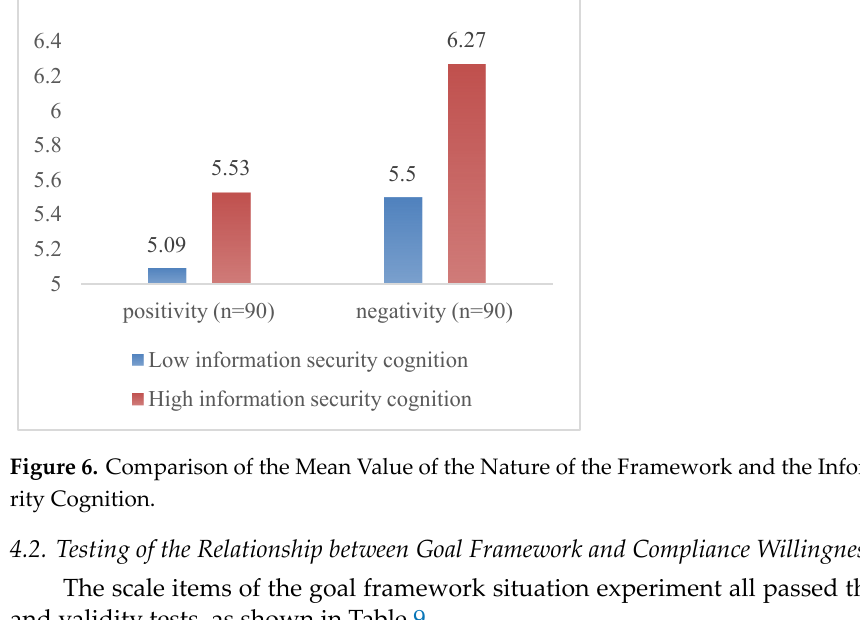
Table 8. Simple Effects (Information Security Cognition and Framework Properties).